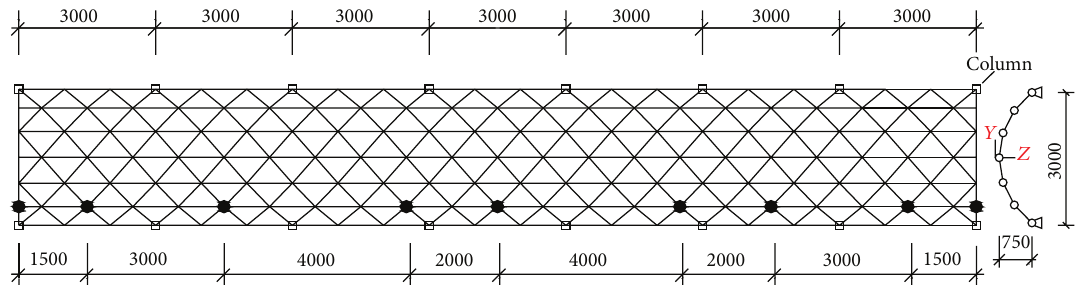
Figure 5: Test model of the reticulated shell (mm), with the measuring point arrangement ( e ), and the node numbering from left to right is 1, 25, 46, 60, 88, 109, 130, 151, and 11, respectively.